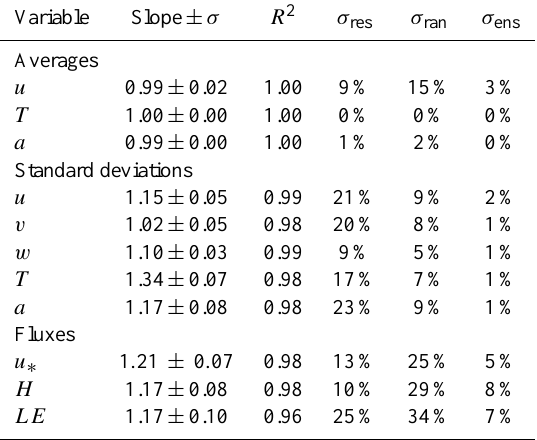
Table 2. Results of the maximum likelihood functional relation- ships between tower and WSMA measurements. Shown are the MLFR slope and its standard error Slope ± σ , weighted coefficient of determination R 2 , residual standard error σ res , the average ran- dom statistical error σ ran and the ensemble random error σ ens